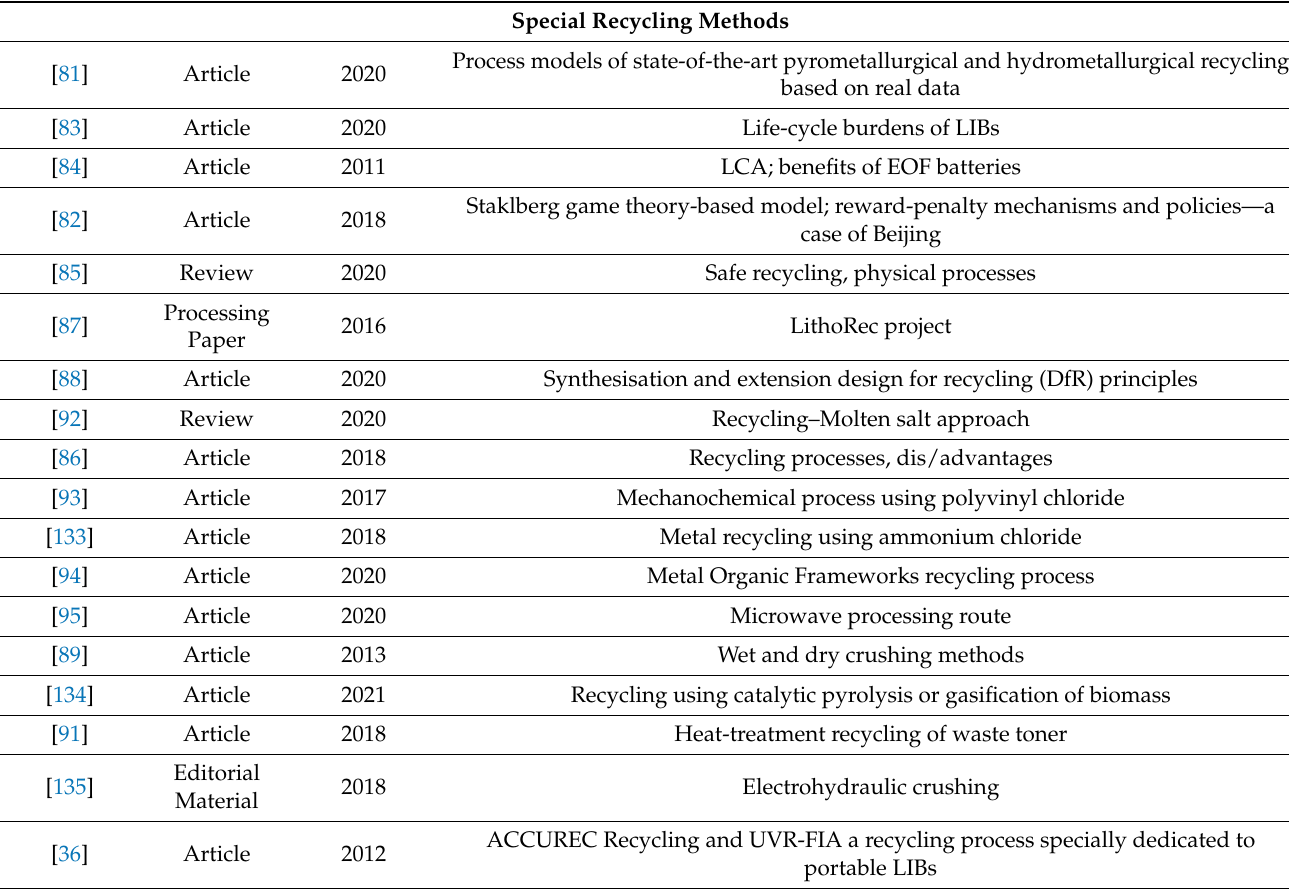
Table A6. Assessed literature in review for “Special Method”